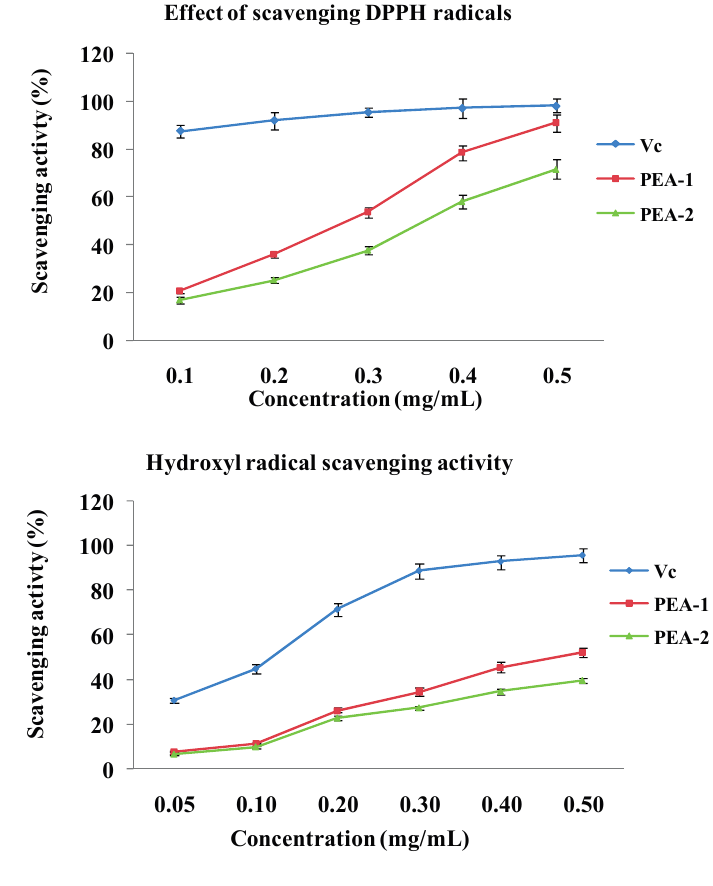
Figure 5. DPPH radical scavenging activities and hydroxyl radical scavenging activities of PEA-1, PEA-2 and Vitamin C (Vc). Each value is the Mean ± standard deviation (SD) of triplicate